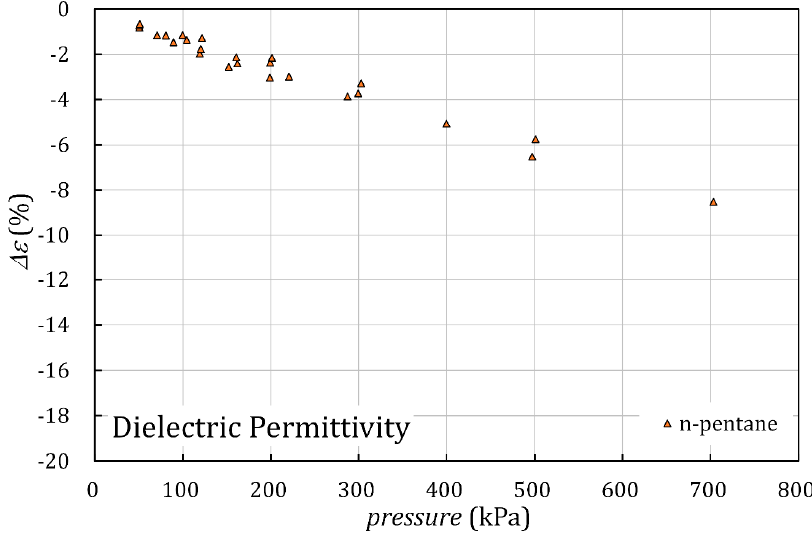
Figure 9. Comparison of the dielectric permittivity of HFE-356mmz with that of n-pentane. The base line corresponds to the dielectric permittivity of HFE-356mmz.